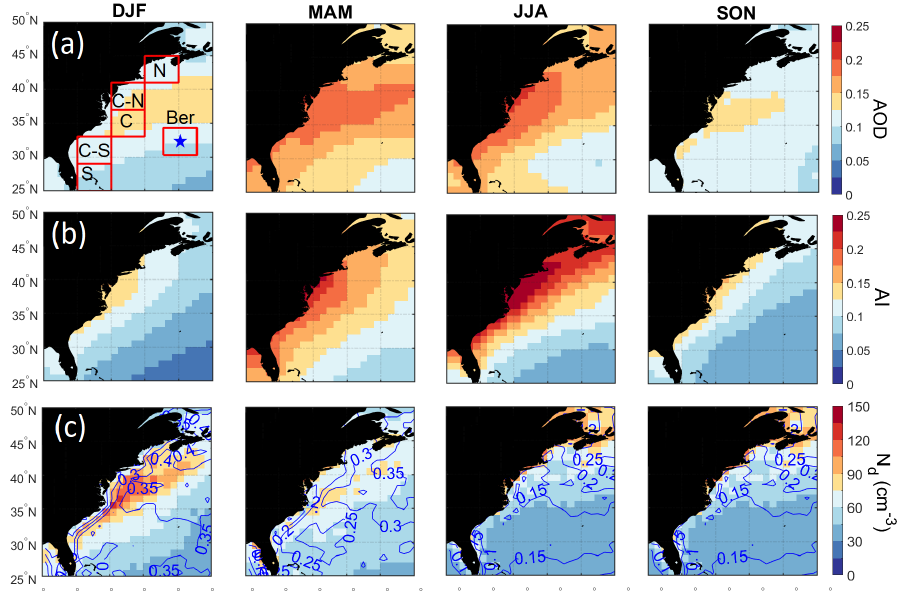
Figure 2. Seasonal spatial maps for (a) MERRA-2 aerosol optical depth (AOD), (b) MERRA-2 aerosol index (AI), and (c) cloud drop number concentration ( N d ) over the western North Atlantic Ocean (WNAO). Contours in panel (c) represent low-level (cloud-top pressure > 700hPa) liquid cloud fraction (CF low-liq. ). Cloud data are based on daily Level 3 data from CERES-MODIS. The maps are based on data between January 2013 and December 2017. The boxes in the top left panel represent sub-domains examined in more detail throughout the study, with the blue star denoting Bermuda.